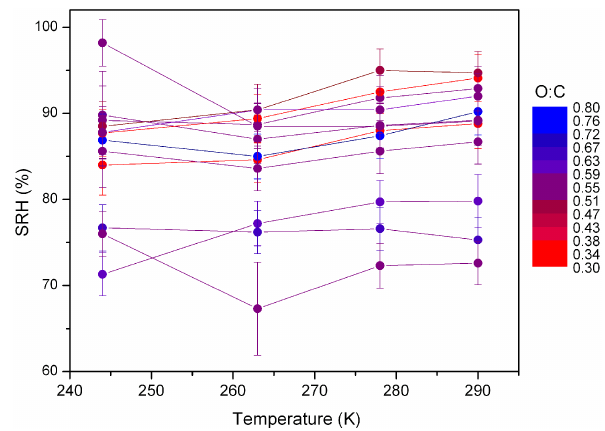
Figure 5. Summary of SRH as a function of temperature for 12 types of mixed organic–ammonium sulfate particles which under- went liquid–liquid phase separation. Data plotted were taken from Table 4. Bars for the data are 95% confidence intervals consider- ing σ of multiple SRH measurements and the uncertainty from the calibration. Colors represent the O:C values of different organic species in the particles. OIR = 2.0 ± 0.1 in all the experiments.